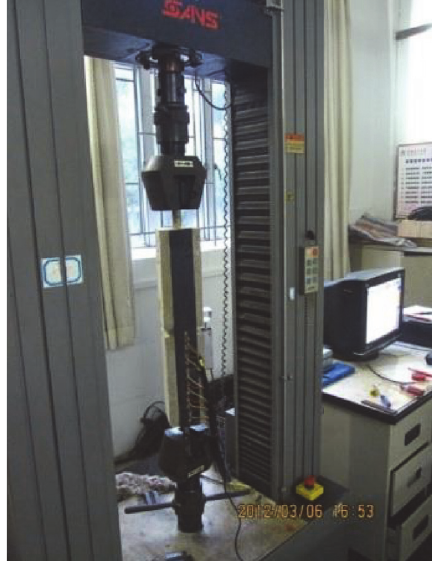
Figure 5: Electronic testing machine (type: